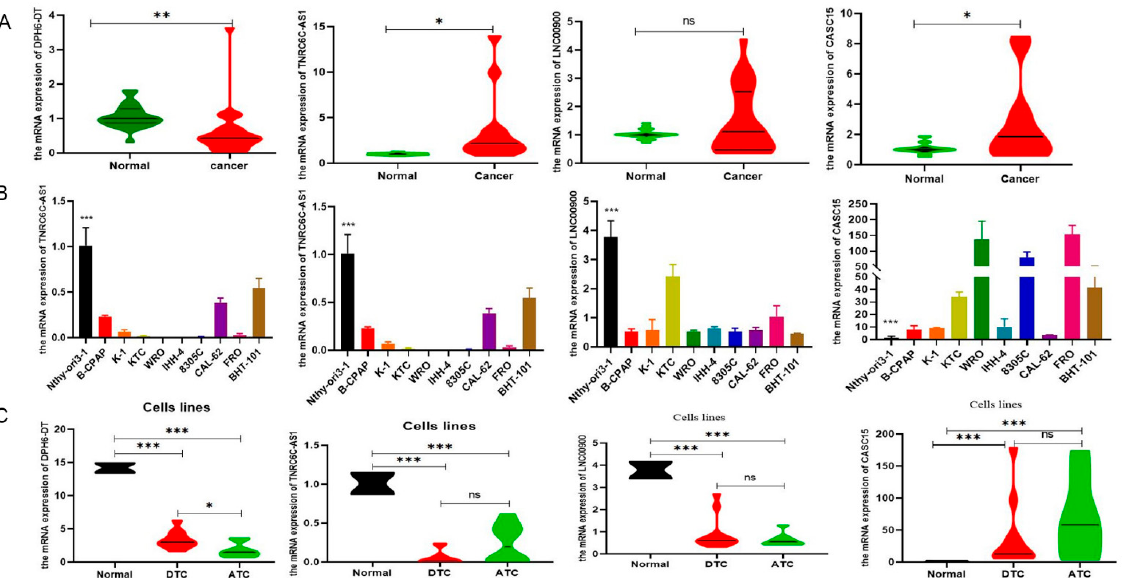
Figure 7. Differential expression of prognostic related DR-lncRNAs. ( A ) Twenty paired PTC samples and adjacent normal tissues. ( B ) Nine thyroid cells and normal thyroid follicular epithelial cells. ( C ) PTC, ATC, and normal thyroid follicular epithelial cells. ATC: anaplastic thyroid cancer. PTC: papillary thyroid cancer. *** p < 0.001, ** p < 0.01, * p < 0.05 and no significance.